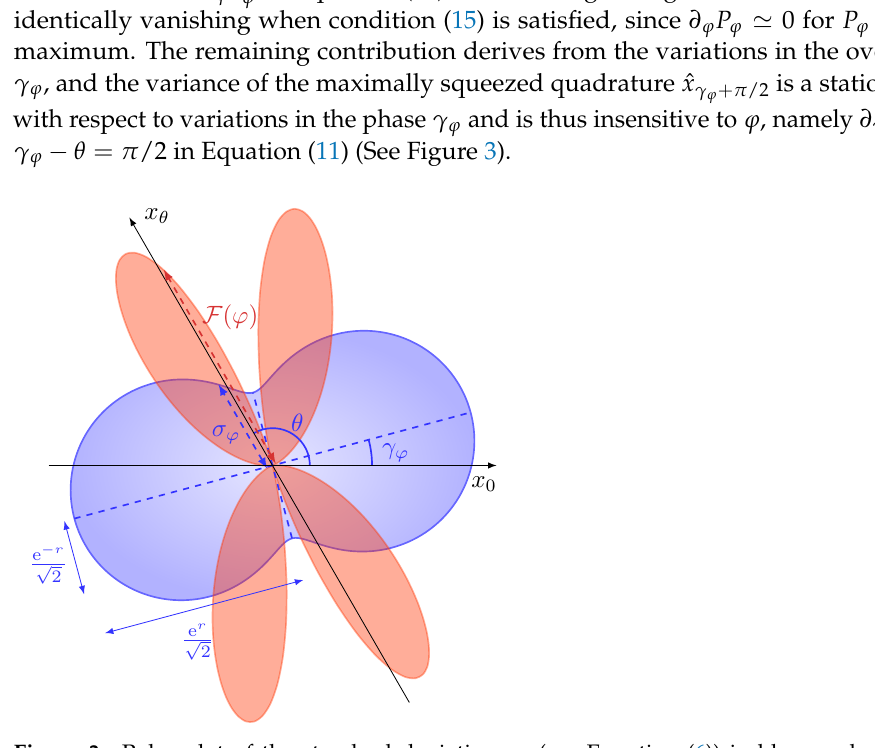
Figure 3. Polar plot of the standard deviation σ ϕ (see Equation (6)) in blue, and of the Fisher ( ϕ ) in Equation (16) in orange as functions of the phase θ of the quadrature ˆ x θ measured, information F ( ϕ ) are reached for θ , satisfying condition (14). Interestingly, for for P ϕ = 1. The large values of F θ = γ ϕ π /2, namely when measuring the quadrature with minimum variance, σ ϕ reaches its ± minimum, but the Fisher information drops to zero: as a squeezing-encoding estimation scheme, this model relies on the information about ϕ inscribed in the variance of the quadrature measured. On the other hand, the minimum variance is a stationary point as a function of ϕ , and thus is locally insensitive to the variations of the parameter. Reprinted with permission from ref. [34], © 2021 The